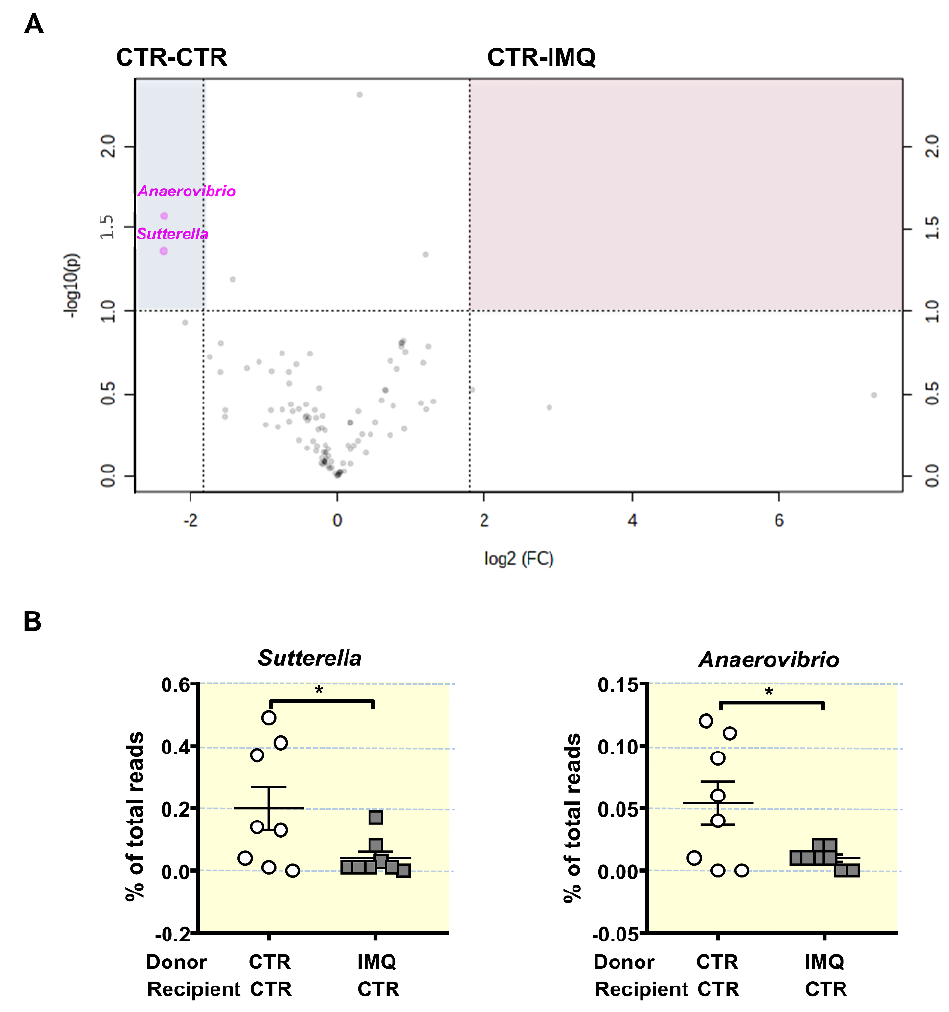
Figure 7. Effects of stool transplantation from imiquimod (IMQ)-treated mice to control mice at the genera proportion in gut microbiota. ( A ) Volcano plot displaying significantly enriched genera in CTR-CTR group or CTR-IMQ group. The x-axis is log2 fold change and the y-axis is transformed p -value. Genera not different between cohorts are shown in black. Features selected by volcano plot with fold change threshold 3.5 and t -test with threshold 0.05. Genera more abundant in CTR-CTR are shown in the upper right, blue-shaded quadrant ( B ) Proportion of key bacterial genera expressed as percentage of total reads. Data is represented as means ± SEM. Unpaired t -test. * p < 0.05 compared to the CTR-CTR group. CTR-CTR, Control mice (CTR) transplanted with microbiota from CTR; CTR-IMQ, CTR transplanted with microbiota from imiquimod (IMQ)-treated